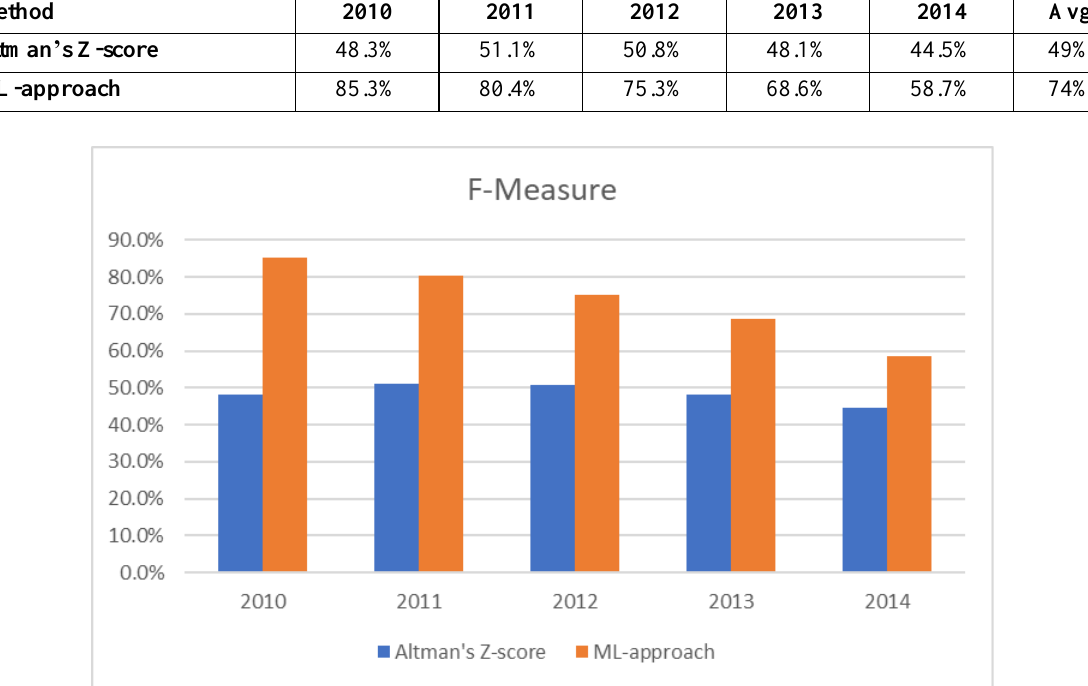
Table 9. F-Measure: Altman’s Z-score VS ML-approach